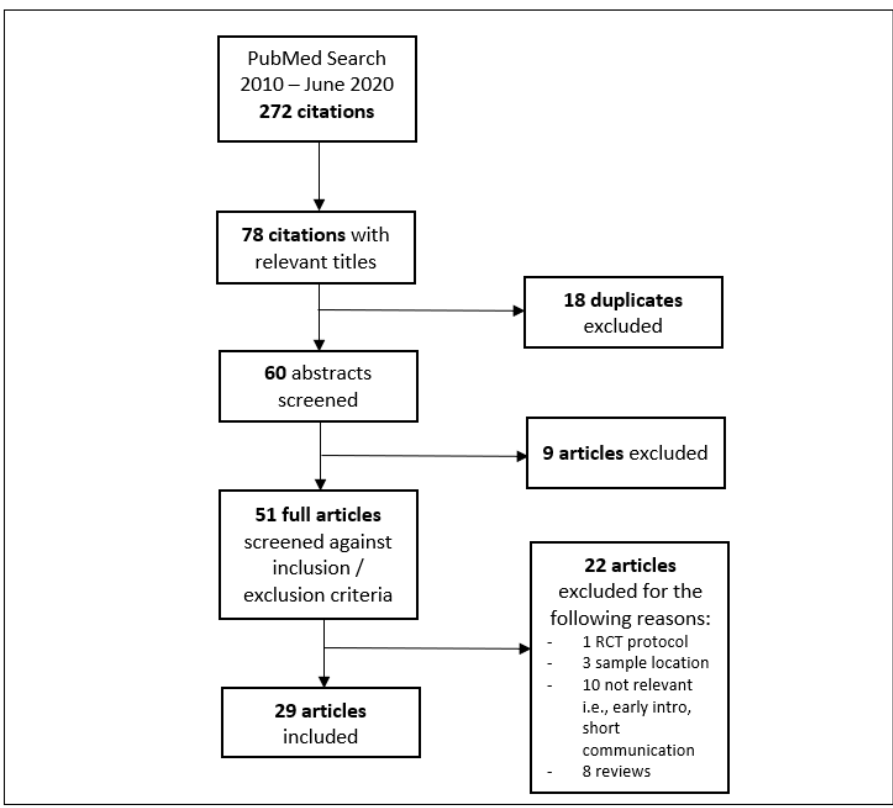
Figure 1. Data extraction process.